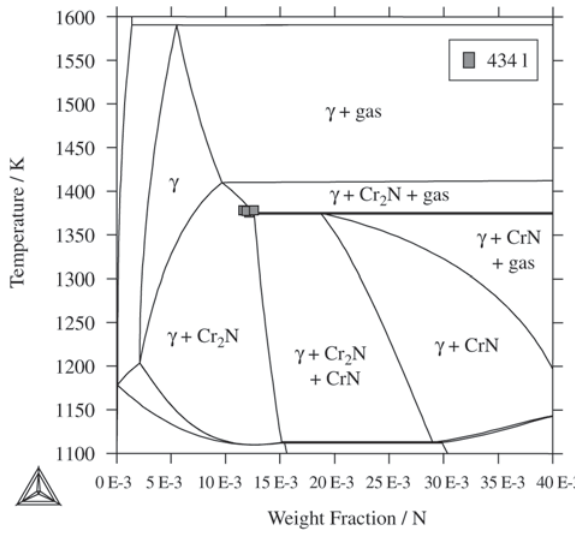
Figure 7. Isopleth of the Fe-16.2% Cr-N phase diagram and 0.36 pressure. The nitrogen contents of the samples are shown MPa N 2 as small squares.